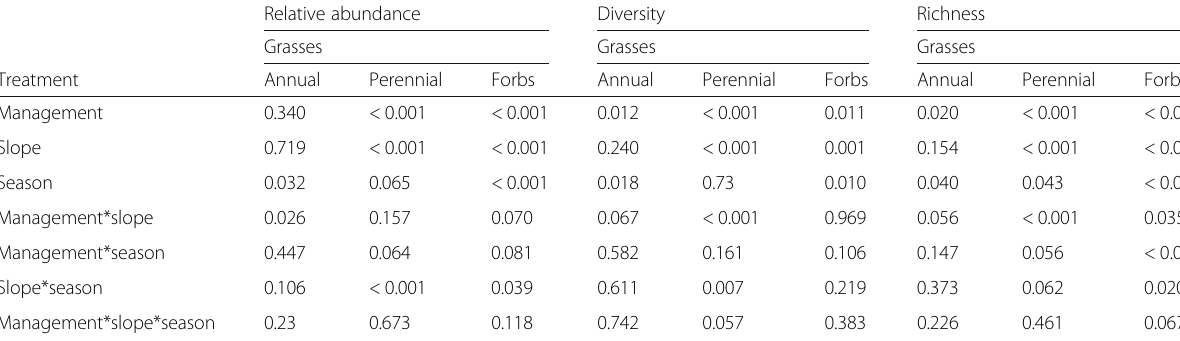
Table 4 Response of herbaceous species richness, diversity, and relative abundance to treatments